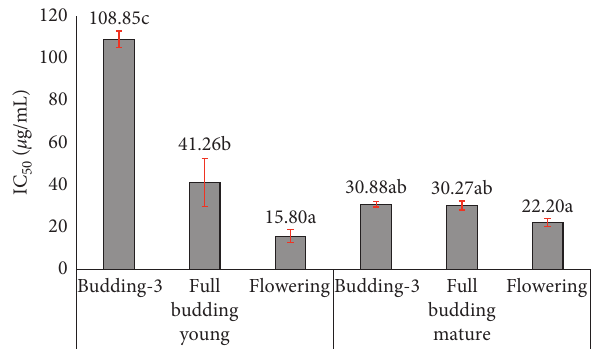
Figure 3: DPPH IC 50 (inhibitory concentration to reduce DPPH radical by 50%) of clove oil at different ages and phenological stages from three replications ( p <